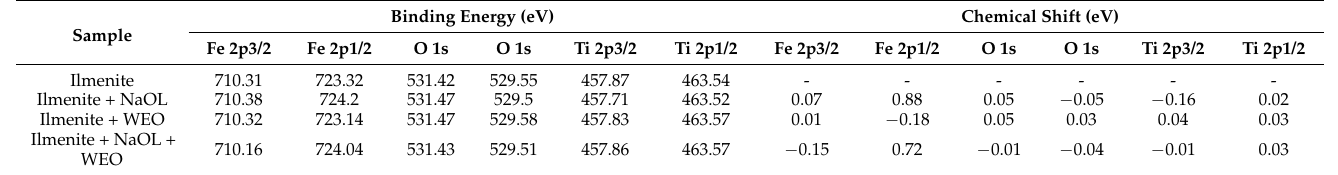
Table 2. Binding energies of elements on the ilmenite surface treated with WEO or/and NaOL (eV).